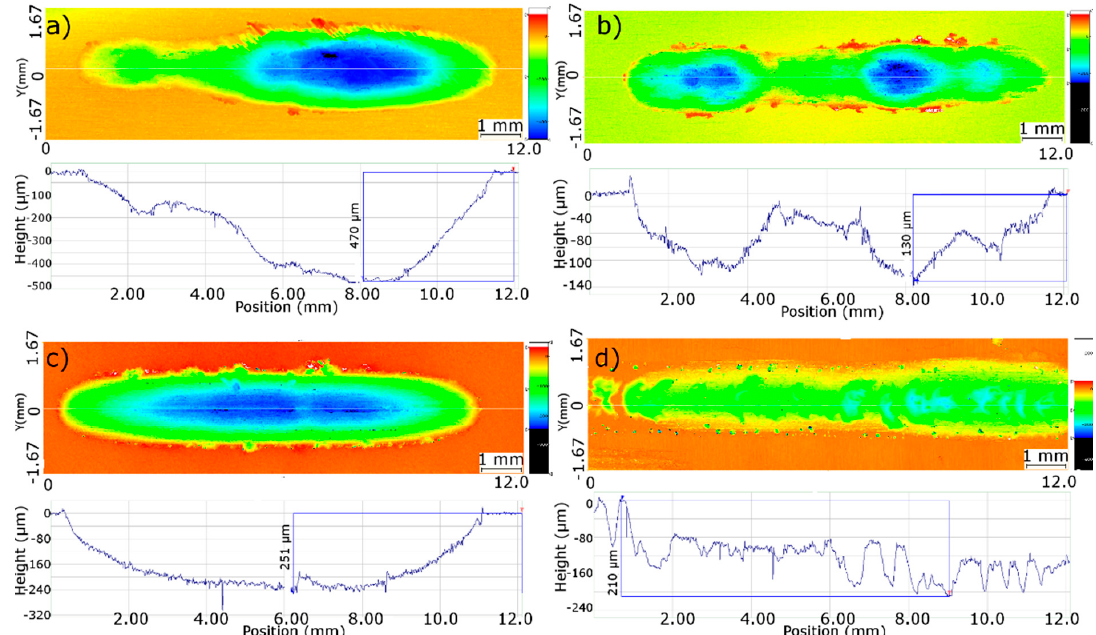
Figure 8. Wear tracks: contours and midline profiles: ( a ) aluminium plate; ( b ) titanium plate; ( c ) as ‐ sprayed titanium coating; ( d ) laser ‐ treated titanium coating.